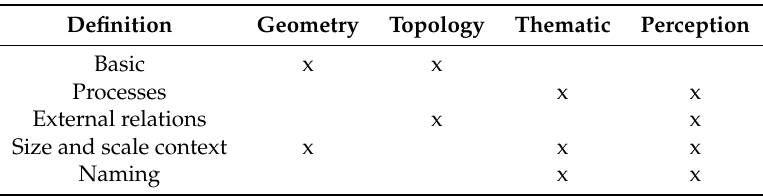
Table 1. Main properties taken into account in landform definitions